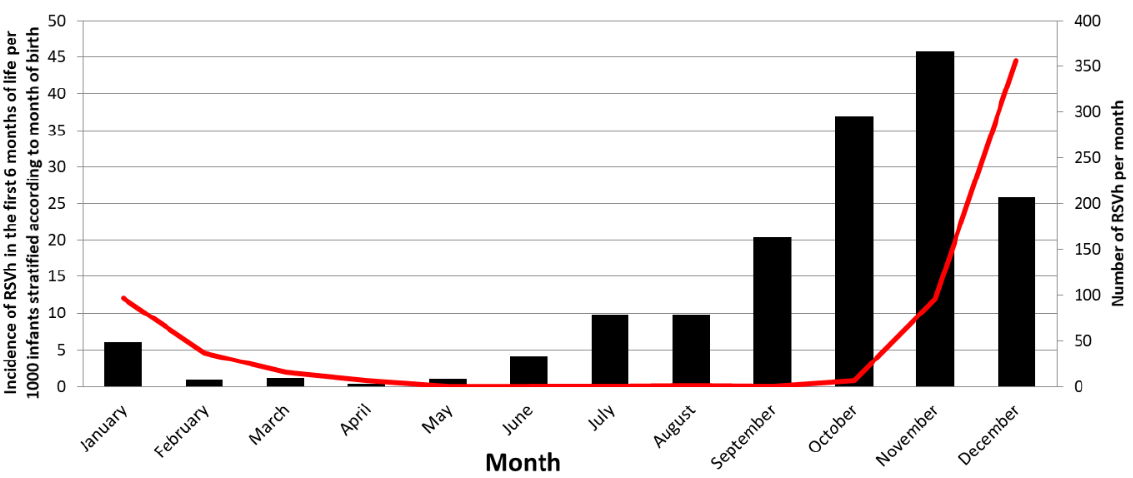
Figure 2. Incidence of infants hospitalised during the first six months of life according to month of birth and number of hospitalisations per month in the studied population. Red line: Number of RSVh per month; Black column: Incidence of RSVh in the first 6 months of life per 1000 infants stratified according to month of birth.